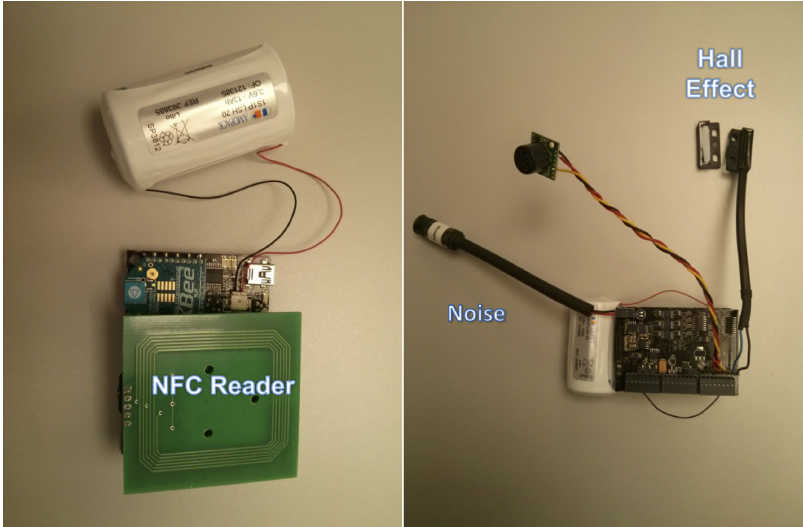
Figure 16. Waspmote with the expansion for the NFC/RFID reader and ZigBee ( left ) and the waspmote with the Hall effect ( right ), both used in Exhibition Room 2